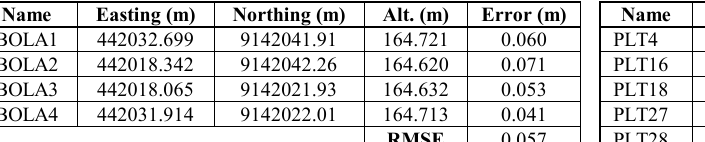
Table 1. Residual table for the georeferencing step of the TLS data using the four artificial spheres.